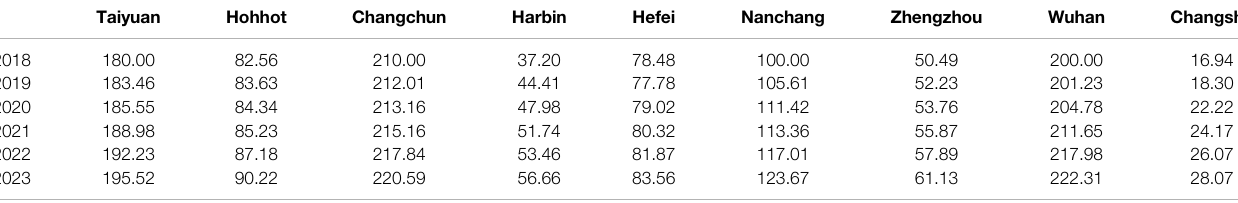
TABLE 4 | Forecast trends in urban household electricity consumption in the Central Region (in billion kWh).